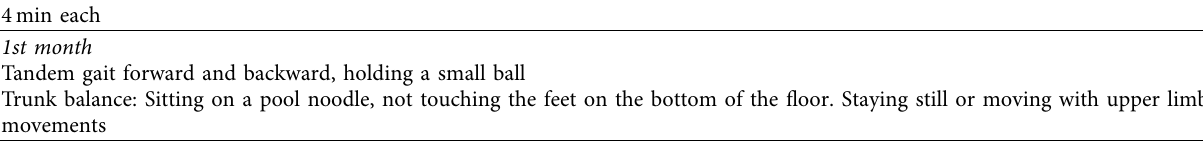
Table 3: Phase of specialized therapeutic exercises.